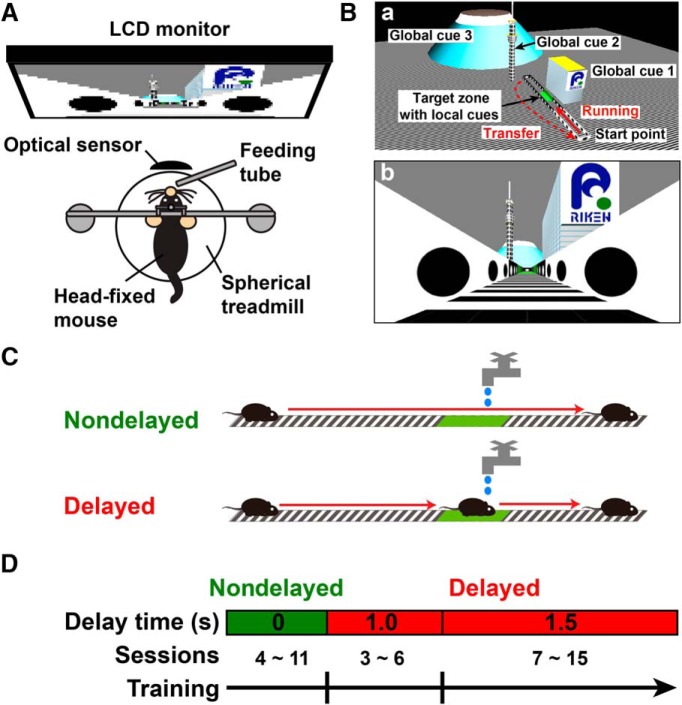
VR setup, task design, and training schedule. A, The VR setup used in this study. A mouse was head-fixed above a spherical treadmill, and the rotation was detected by an optical motion sensor. The signal was fed to a program that renders VR scenes as visual feedback on a wide LCD monitor placed in front of the mouse. A water reward was delivered through a feeding tube put in front of the mouse’s mouth. Ba, A bird’s-eye view of the virtual linear track with local and global visual cues. A mouse starts running along the virtual linear track unidirectionally from one end (start point) to the other. On arrival at the far end, the mouse’s position is set back to the start position (transfer). The target zone defined in the middle is denoted with green panels on the walls and floor (target zone with local cues). Large objects put outside the track serve as global cues. Bb, A camera view of the virtual linear track. C, Schematic representation of two different versions of the task. In the nondelayed task, mice are rewarded immediately whenever they enter the target zone. In the delayed task, mice need to stay in the target zone for a period of 1.0–1.5 s to receive the reward. D, The training schedule. Training starts with several sessions of the nondelayed task, followed by the delayed task with increasing periods of time from 1.0–1.5 s.